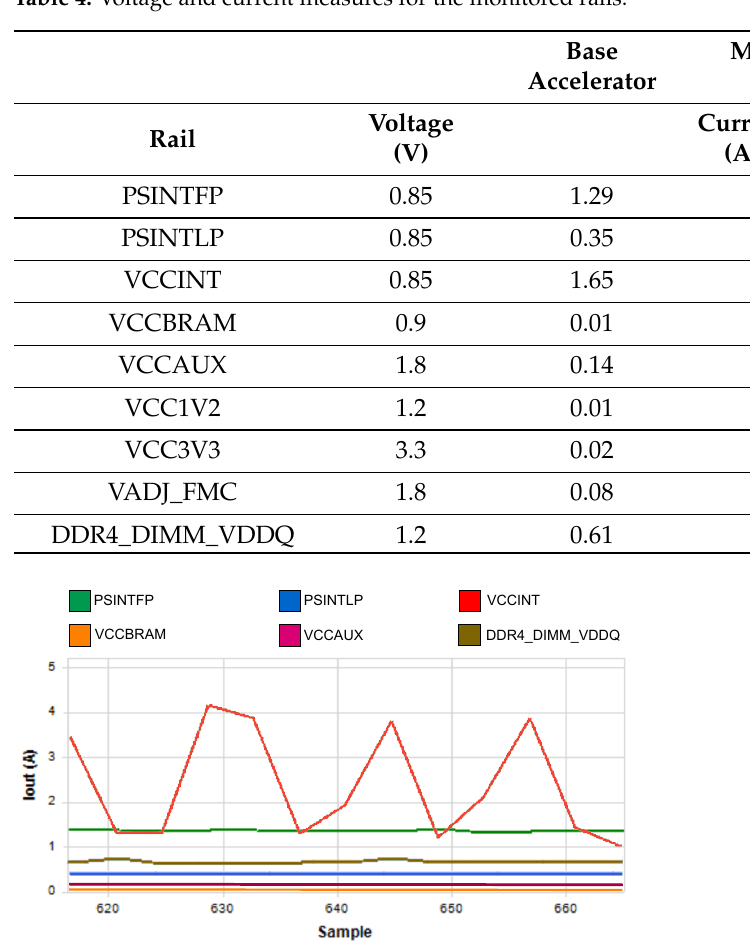
Table 4. Voltage and current measures for the monitored rails.